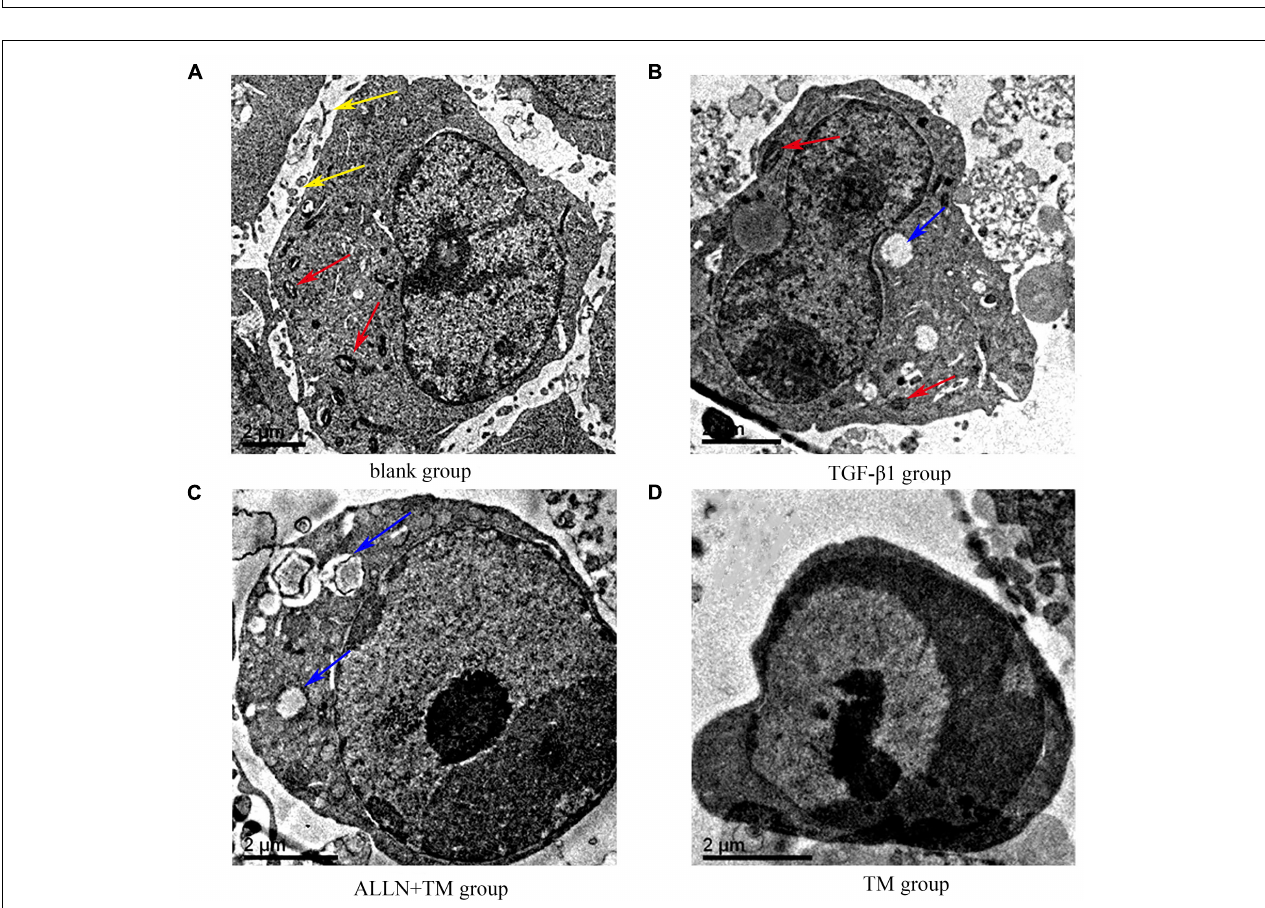
FIGURE 2 | The ultrastructural changes of HSC in each group. (A) Control group was cultured in complete medium for 48 h. (B) TGF- β 1 group was cultured with TGF- β 1 blank medium for 48 h. (C) TGF- β 1 + ALLN + TM group was cultured with the same concentration of TGF- β 1 blank culture medium for 24 h, then pretreated with ALLN for 30 min and added TM for 24 h. (D) TGF- β 1 + TM group was incubated with TGF- β 1 blank medium for the same time, then added TM for 24 h; yellow arrows marked the villi, red arrows marked the mitochondria, and blue arrows marked the vacuoles. TM, tunicamycin; ALLN, N-acetyl-leu-leu-norleucinal; HSC, hepatic stellate cell; TGF- β 1, transforming growth factor- β